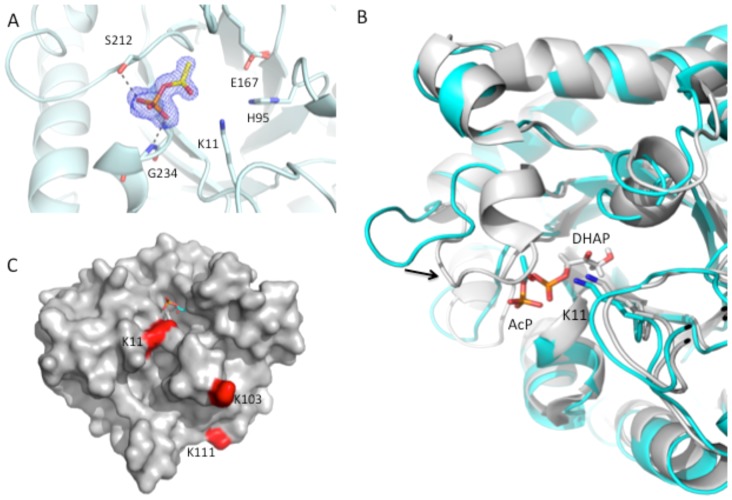
Crystal structure of E. coli triose phosphate isomerase (TpiA) determined in the presence and absence of acP.
A) Cartoon and stick representation of acP bound in the active site of TpiA. The acP ligand is surrounded by the Fo-Fc omit map that was contoured at the 3 sigma level. Side-chain and main-chain interactions with acP are shown as gray dashed lines. Oxygens are shown in red, nitrogens in blue, phosphate in orange, carbons of acP in yellow, and carbons of the protein in light blue. B) Overlay of the crystal structure of the E. coli acP-bound TpiA protein (PDB ID: 4MVA, cyan) with the crystal structure of TpiA from Saccharomyces cerevisiae (PDB ID: 1NEY, gray). The S. cerevisiae structure has the substrate 1,3-dihydroxyacetone phosphate (13P) bound in its active site. K11 is shown in each structure. Nitrogen atoms are blue, oxygens are red, the carbon atoms of acP are cyan and carbon atoms of 13P are gray. An arrow indicates the movement for loop closure between open (cyan) and closed (gray) forms of the protein. C) Surface representation of TpiA (PDB ID: 4MVA) with the locations of up-regulated acetylated lysine residues in the ackA mutant highlighted in red. AcP is bound in the active site.